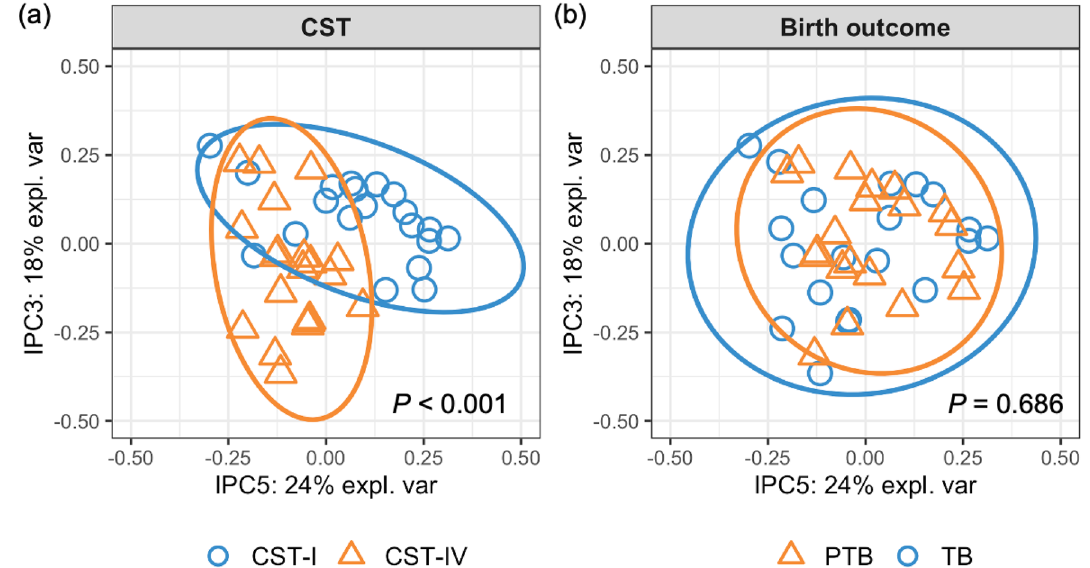
Figure 1. The cervicovaginal metabolome clusters by community state type (CST). Independent principal component analysis (IPCA) plots of metabolite profiles colored by CST ( a ) and birth outcome ( b ). Blue dots indicate CST I samples in ( a ) and term birth (TB) samples in ( b ); yellow triangles indicate CST IV samples in ( a ) and spontaneous preterm birth (sPTB) samples in ( b ); circles indicate the 95% confidence ellipse of samples. p values of permutational multivariate analysis of variance (PERMANOVA) are shown in each panel. The two components with the largest explained variance of metabolite composition, IPC 5 (24%) and IPC 3 (18%), are